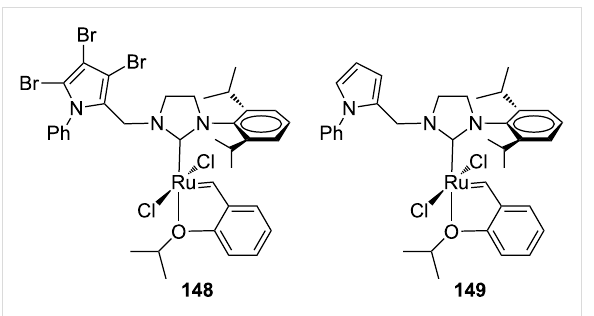
Figure 28: Hoveyda-type complexes 148 and 149 with N -phenyl- pyrrole, N’ -mesityl NHCs.